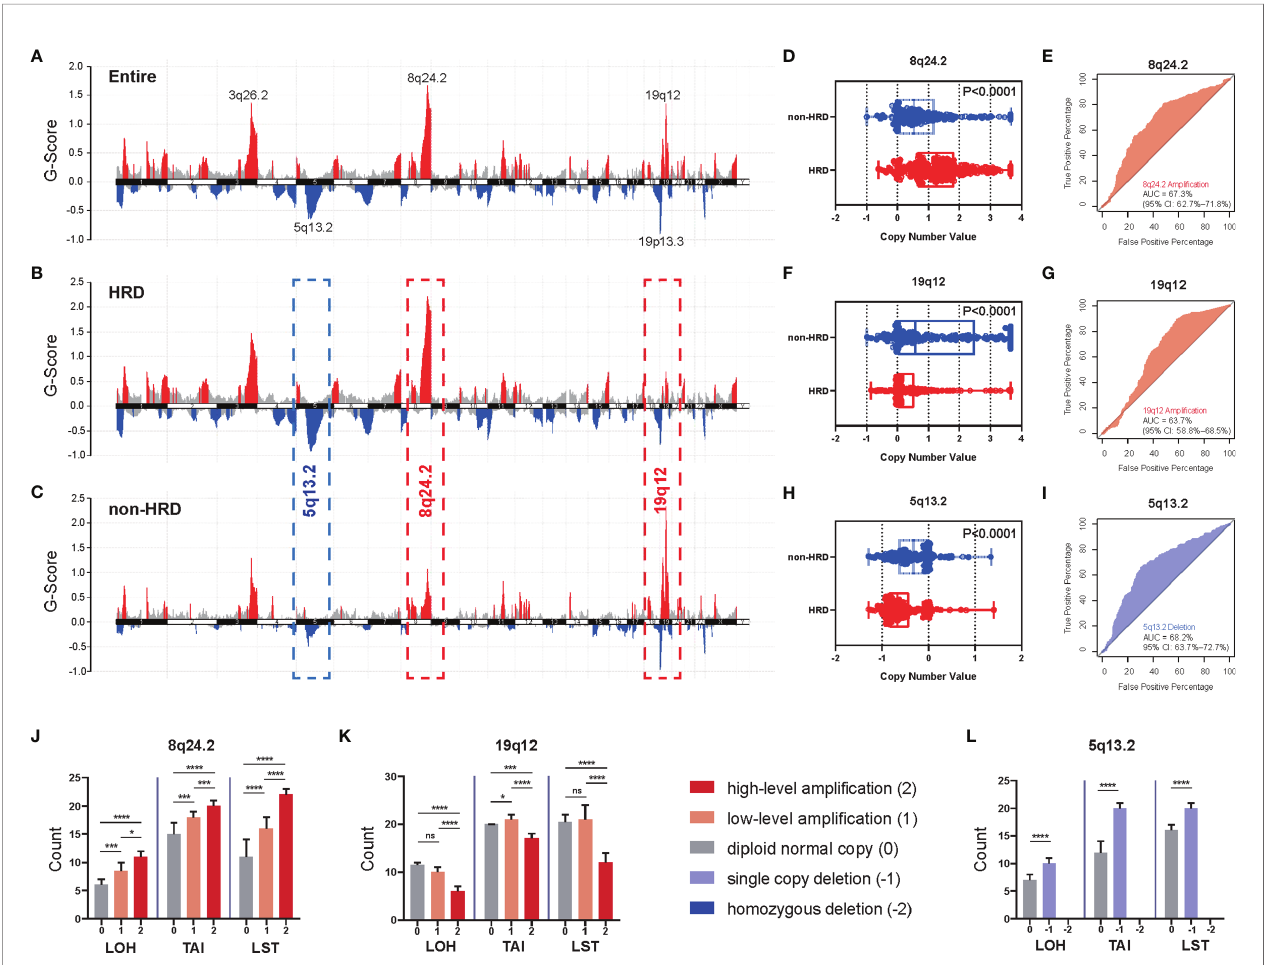
FIGURE 1 | The CNVs of speci fi c chromosomal fragments associated with HRD status in ovarian cancer. (A) The enrichment score of genome copy number variations (CNVs) in all ovarian cancer patients from the TCGA dataset. (B – I) According to HRD score, patients with ovarian cancer were divided into an HRD group (HRD score ≥ 42) and a non-HRD group (HRD score < 42). (B) Enrichment score of CNVs in the HRD group. (C) Enrichment score of CNVs in the non-HRD group. Red: ampli fi cation, blue: deletion. (D, F, H) Differences of copy number value of 8q24.2 (D) , 19.12 (F) , and 5q13.2 (H) calculated by GISTIC between the HRD group and the non-HRD group. (E, G, I) Performance of 8q24.2 ampli fi cation (E) , 19q12 ampli fi cation (G) , and 5q13.2 deletion (I) in predicting HRD/non-HRD. (J – L) According to the cutoff given by GISTIC 2.0, we divided the copy number variation states of 8q24.2 (J) , 19q12 (K) , and 5q13.2 (L) into fi ve categories: high-level ampli fi cation (red), low-level ampli fi cation (orange), diploid normal copy (gray), single copy deletion (purple) and homozygous deletion (blue), and explored the relationship between them and the three constituent indexes of HRD score — LOH, TAI, and LST. Statistical analysis was performed by Wilcoxon signed rank test. Signi fi cant levels: ns, not signi fi cant; * p < 0.05; *** p < 0.001, **** p <